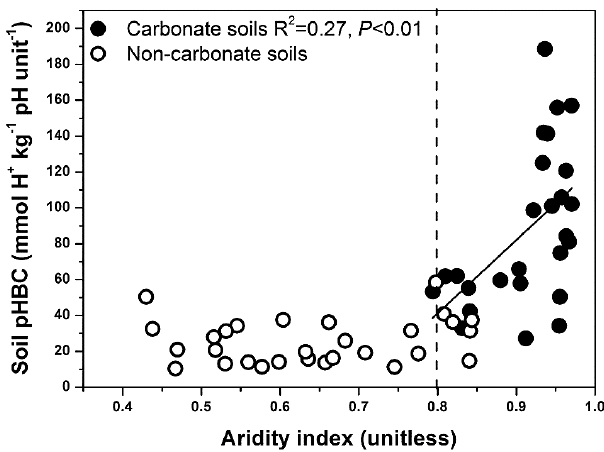
Figure 3. Relationships between soil pH buffering capacity (pHBC) and aridity index in the carbonate-containing soils (solid circles) and the non-carbonate-containing soils (empty circles). Dashed line represents the boundary between the arid regions (aridity index >0.8) and the semi-arid regions (aridity index <0.8). All the re- gression results can be found in Table